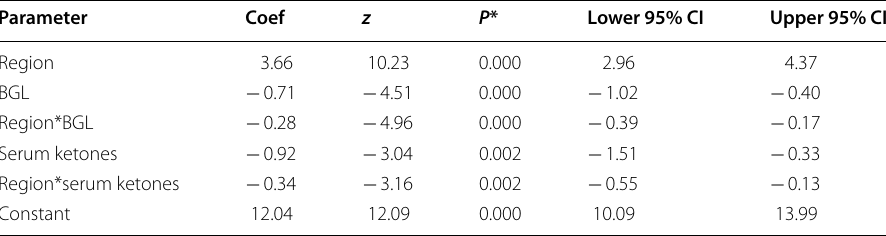
CI confidence interval *Statistical significance ( P <